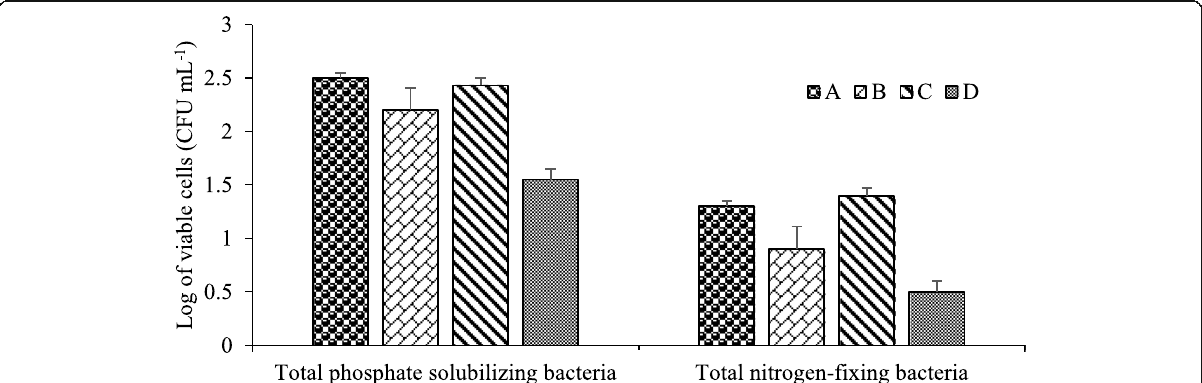
Fig. 1 Populations of phosphate solubilizing and nitrogen-fixing (diazotrophic) bacteria for reactors A, B, C, and D. Error bars indicate standard